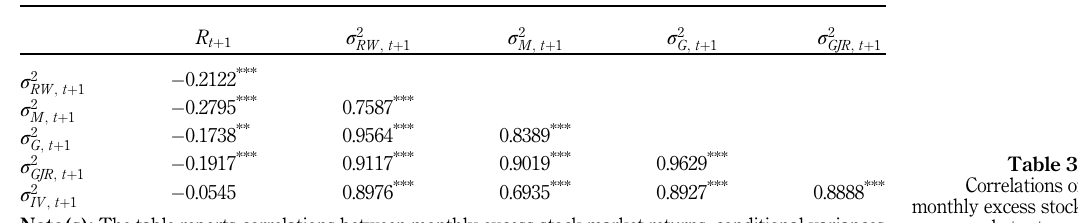
Table 3. Correlations of monthly excess stock market returns,